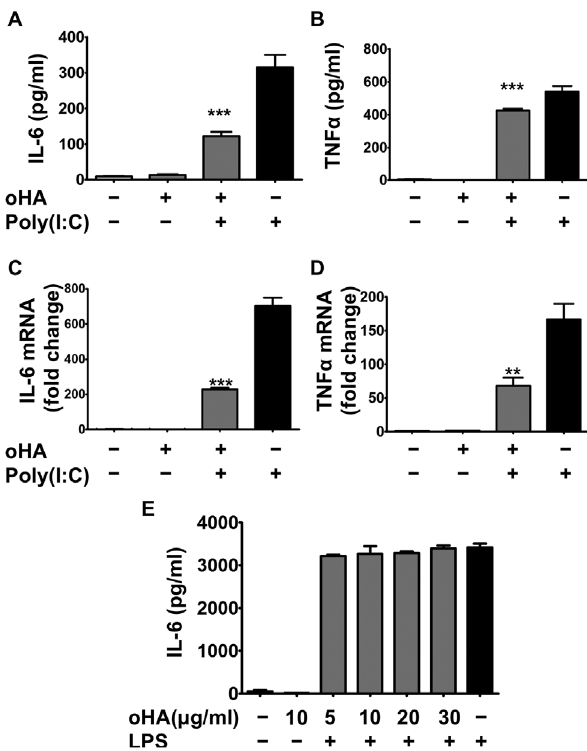
Figure 2. Oligo-HA suppresses poly(I:C) induced, but not LPS- induced cytokine release in MH-S cells. MH-S cells were treated with vehicle (PBS), oligo-HA (10 m g/ml), oligo-HA + poly(I:C) (10 m g/ml), or poly(I:C) alone for 24 h. IL-6 (A) and TNF a (B) release in the cultured media was measured by ELISA. mRNA abundance for IL-6 (C) and TNF a (D) was assessed 4 h after treatment by quantitative RT-PCR. Quantitative RT-PCR data are shown as relative expression as compared with vehicle-treated macrophages. (E) MH-S cells were treated with 100 ng/ml LPS in the presence or absence of oligo-HA for 24 hours. IL-6 release in the cultured media was measured by ELISA. Data are representative of five independent experiments with n=3 per group and are means 6 S.E.M. ***: p , 0.001. **: p , 0.01.